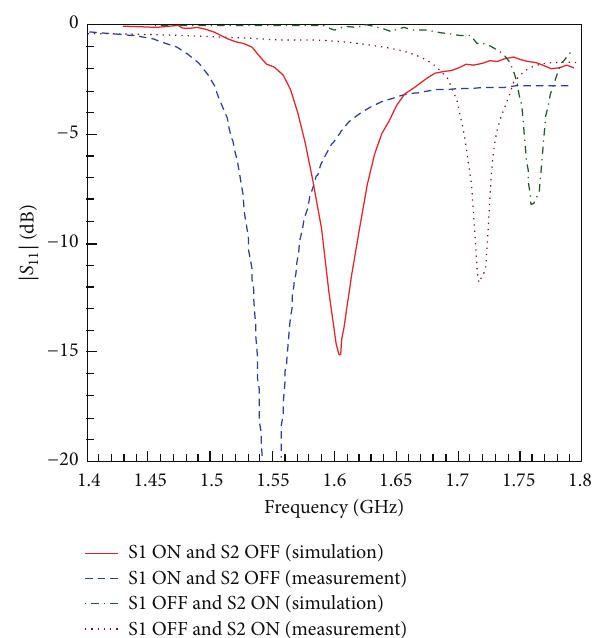
Figure 7: Measured and simulated impedance mismatch of the fabricated prototype of the single NFRP element reconfigurable